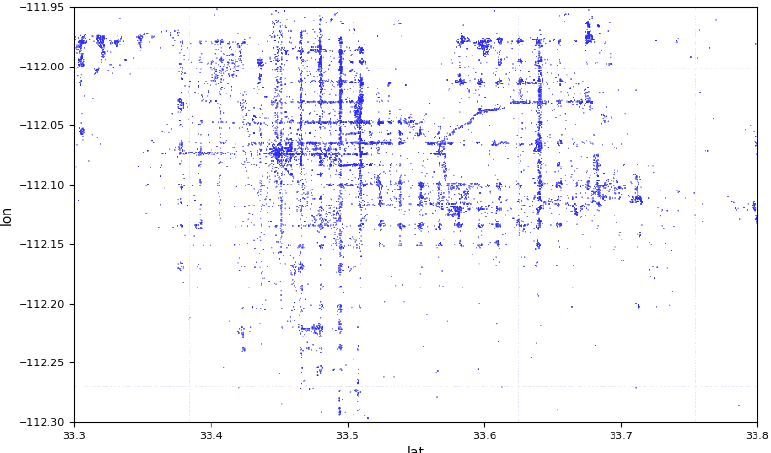
Figure 4. The user visiting locations (Phoenix). Each point represents a user visiting a real-world geographical location. (Abscissa: the latitude; Ordinate: the